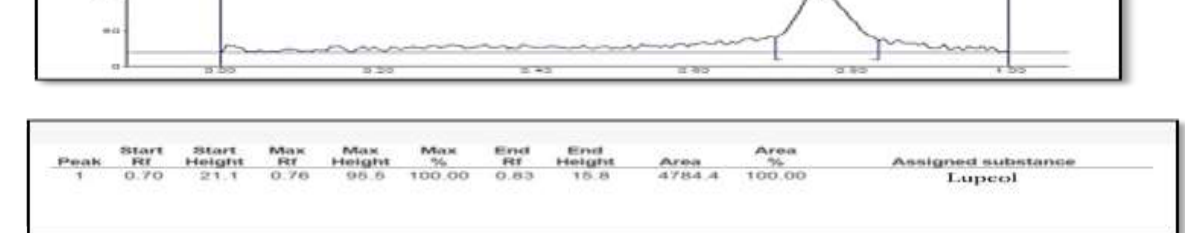
Figure 7. HPTLC chromatogram of Lupeol standard.